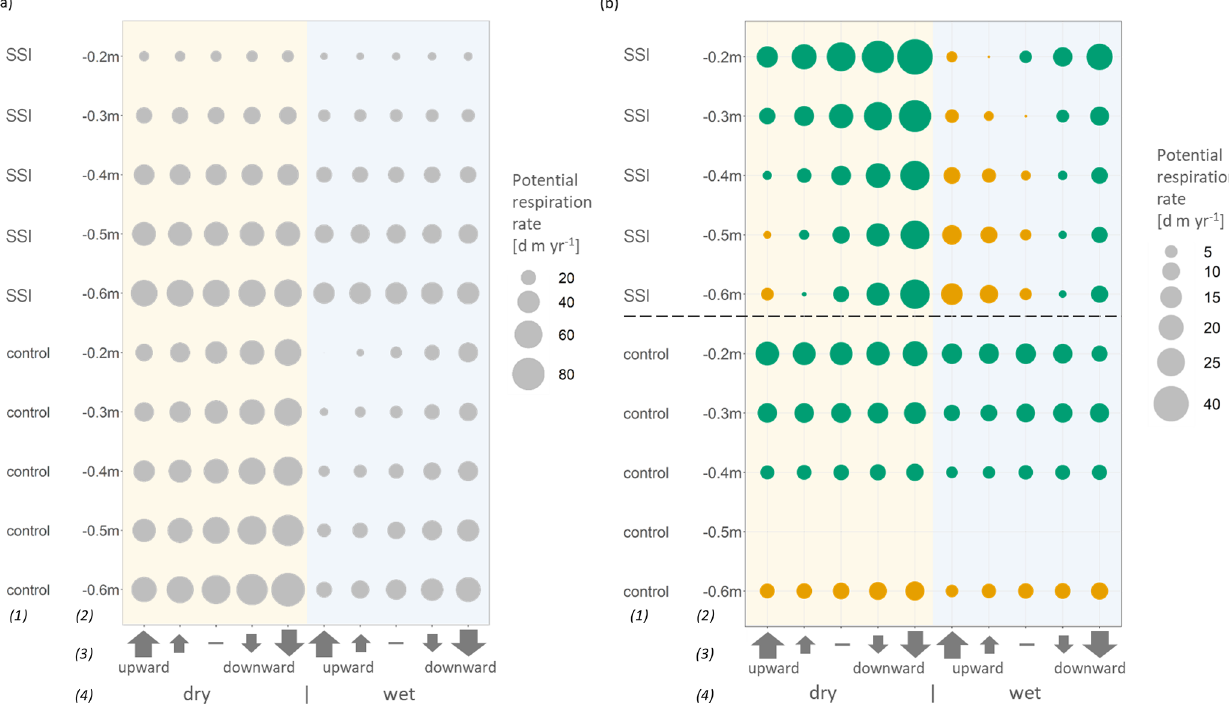
with factor > 1 . 5 for a dry year (Table S9), which